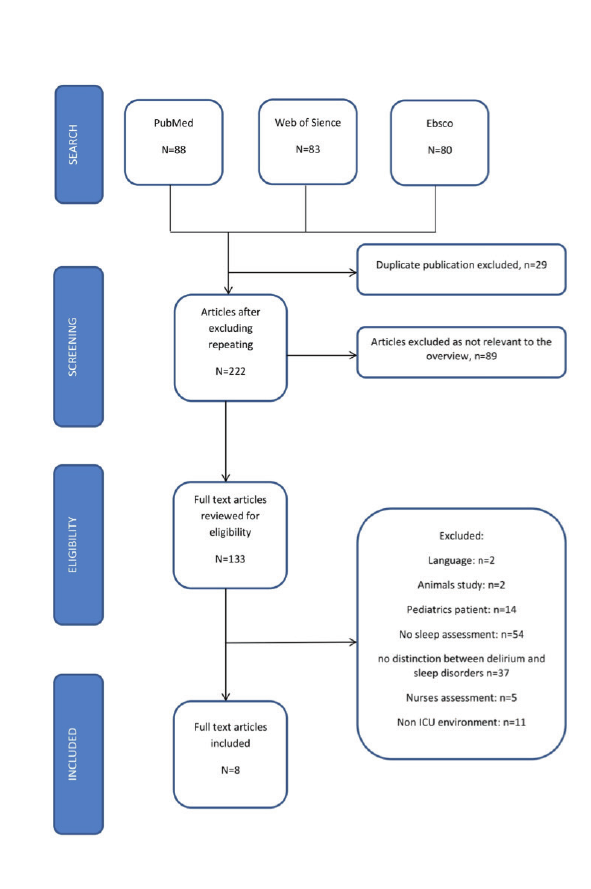
Figure 1: Scheme for articles qualified for a systematic